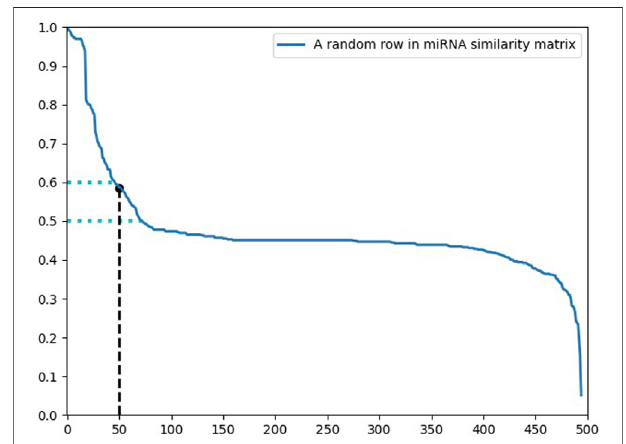
FIGURE 5 | The distribution of a similarity sequence.